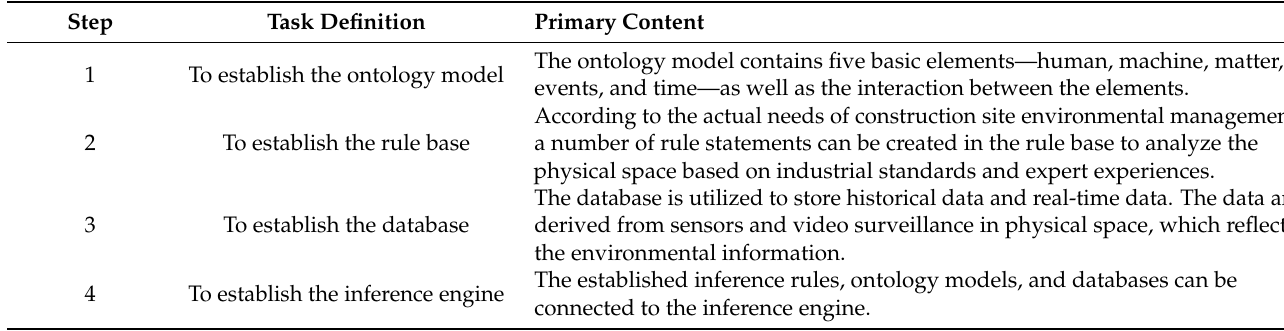
Table 2. The process of ontology modelling in the